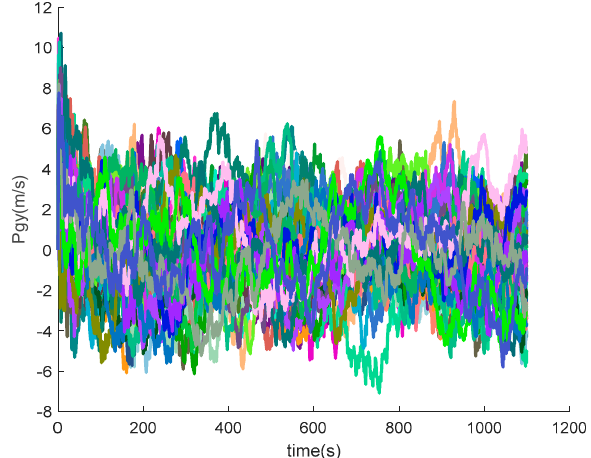
Figure 23. The y -axis position errors of SINS / GPS in the LCEF frame.